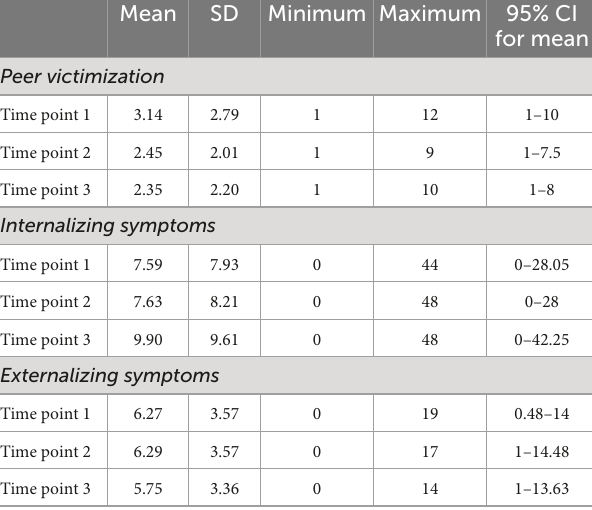
TABLE 2 Descriptive statistics of peer victimization and internalizing and externalizing symptoms at each assessment time point.